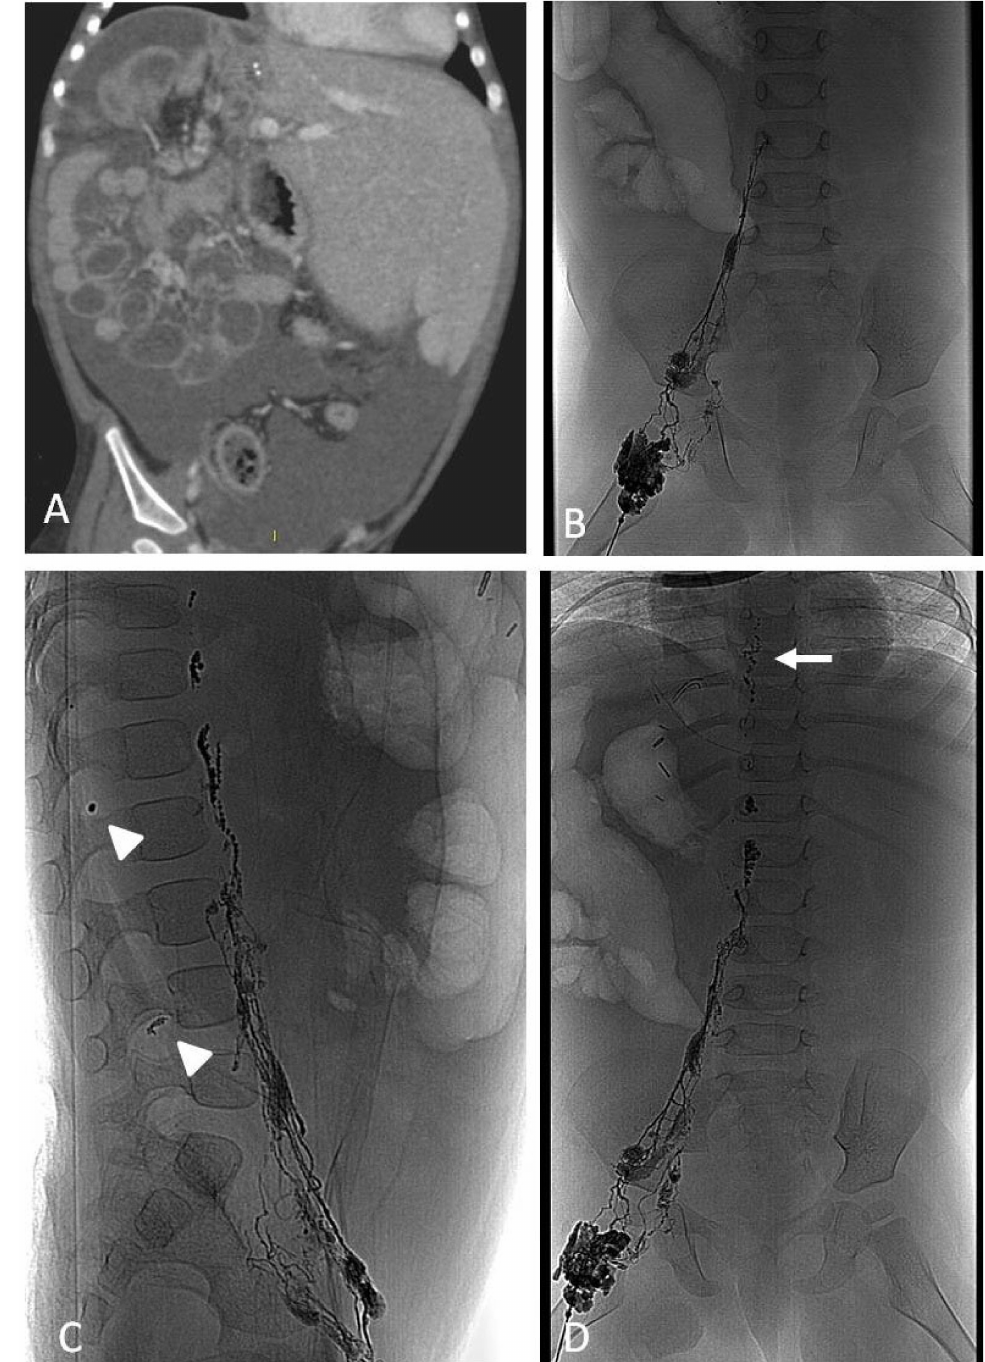
Figure 9. Percutaneous lymphangiography and sclero-embolization of chilous ascites, due to lym- phatic leakage after liver transplant in a 3-year-old female. ( A ) Reformatted coronal Computed Tomography image shows abundant ascites. ( B ) Fluoroscopic image shows the ethiodized oil contrast medium injected into the groin lymph nodes spreading through the iliac lymphatics. ( C ) Abdominal X-rays lateral view shows extravasation (arrowheads) of ethiodized oil confirming the lymphatic leakage. ( D ) X-rays frontal panoramic view shows partial opacification of the lymphatic ducts up to the thoracic duct (arrow). After percutaneous lymphangiography the ascites progressively reduced up to complete resolution in few